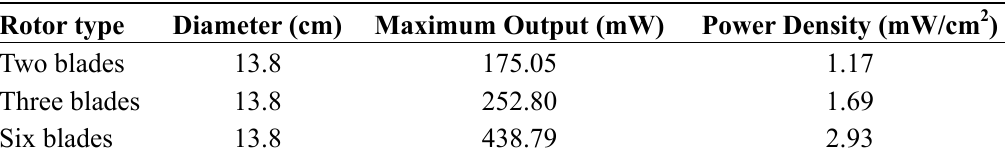
Table 5. Output power with different type of rotors.